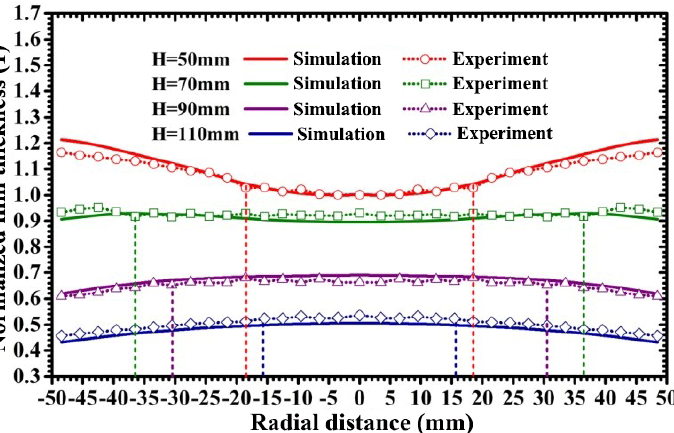
Figure 7. Normalized film thickness distribution curves under various target-substrate distances. In order to explore the variation mechanism of film uniformity and deposition rate with target-substrate distance, the thickness distributions of films deposited on the sta- tionary substrate (substrate does not rotate) under different target-substrate distances were calculated. The thickness distribution nephograms of the films deposited on the cir- cular region with a diameter of 300 mm under different target-substrate distances are dis- played in Figure 8a, in which substrate regions are marked with circular dotted lines. Fig- ure 8b,c, depict the 3D nephograms and the corresponding section profiles of the film thickness distribution on the stationary substrate, respectively. It can be seen from the leftmost subgraph of Figure 8a that, when the target-substrate distance is 50 mm, the film thickness distribution nephogram on the circular region has three 120° uniformly distrib- uted peak points, which are near the margin of the substrate, and the film thickness at these peak points are significantly greater than that at the substrate center. This indicates that when the target-substrate distance is 50 mm, a considerable part of the sputtered par- ticles from three targets are not deposited within the substrate region. Accordingly, the loss of sputtered particles leads to the low deposition rate of sputtered particles on the substrate, and the preferential deposition of sputtered particles near the edge of the sub- strate results in the U-shaped film thickness distribution on the rotating substrate. As tar- get-substrate distance increases from 50 mm to 110 mm, the three peaks of film thickness distribution nephograms gradually enter the substrate region and approach the substrate center. This allows more sputtered particles to be deposited on the substrate, resulting in a significant increase of the deposition rate on the substrate. Furthermore, as the three peak points of film thickness distribution nephograms gradually approach the substrate center, the sputtered particle flows from the three sputtering targets superimpose in the region near the substrate center, leading to the significant increase of the film thickness at this region. Consequently, the film thickness profile on the rotating substrate gradually changes from a U-shaped curve to a saddle-shaped curve, and then to an arch-shaped curve, as shown in Figure 8c.